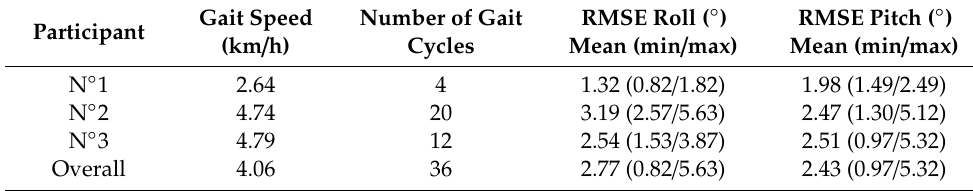
Table 3. Attitude estimation for each participant (mean(min / max)). The roll and pitch angles are in the frontal and sagittal planes respectively.